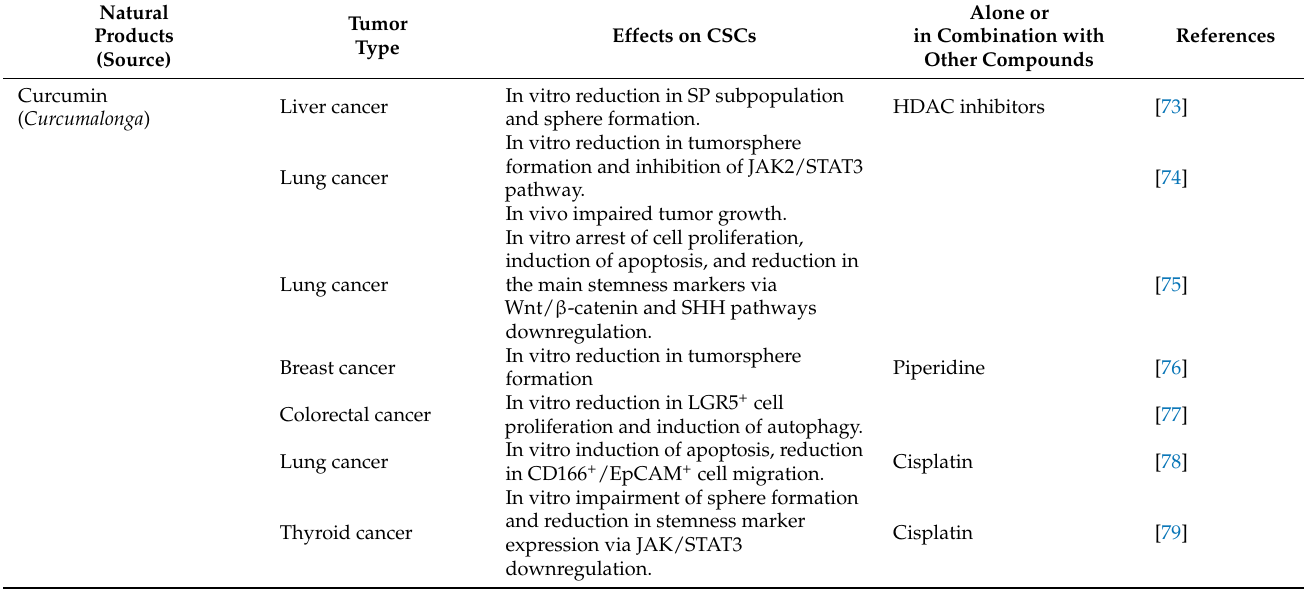
Table 1. NPs derived from dietary sources and effects on